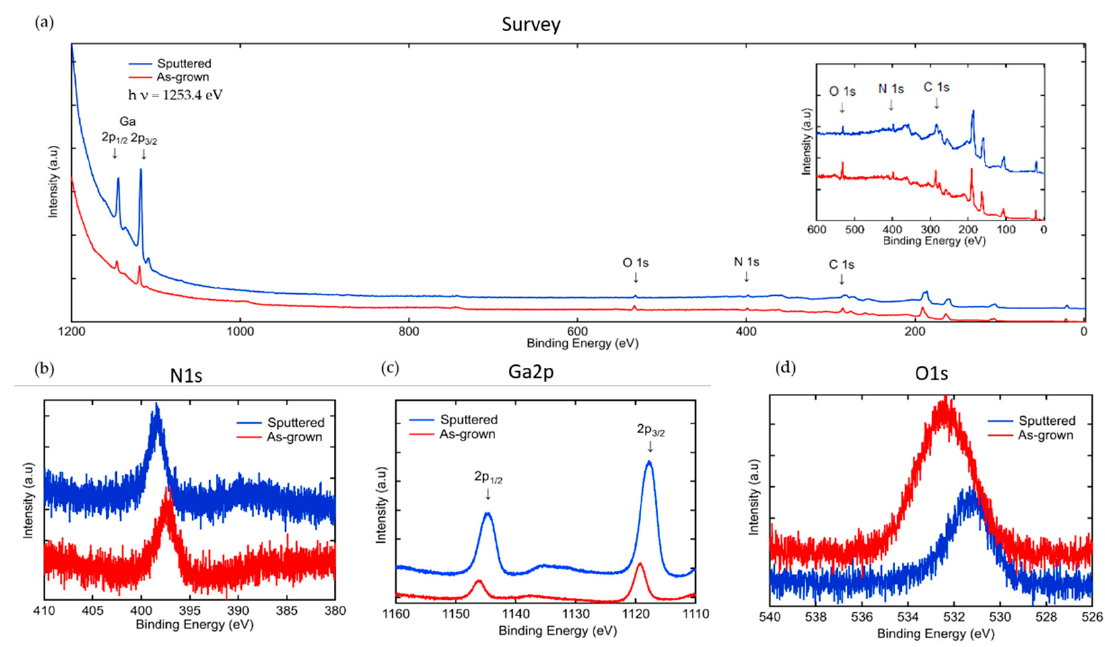
Figure 3. X-ray photoelectron spectroscopy (XPS) spectra comparing as-grown and sputtered GaN thin film grown at 800 ◦ C, including ( a ) a survey scan with inset from 0 to 600 eV and core level states of ( b ) N 1s, ( c ) Ga 2p, and ( d ) O 1s.